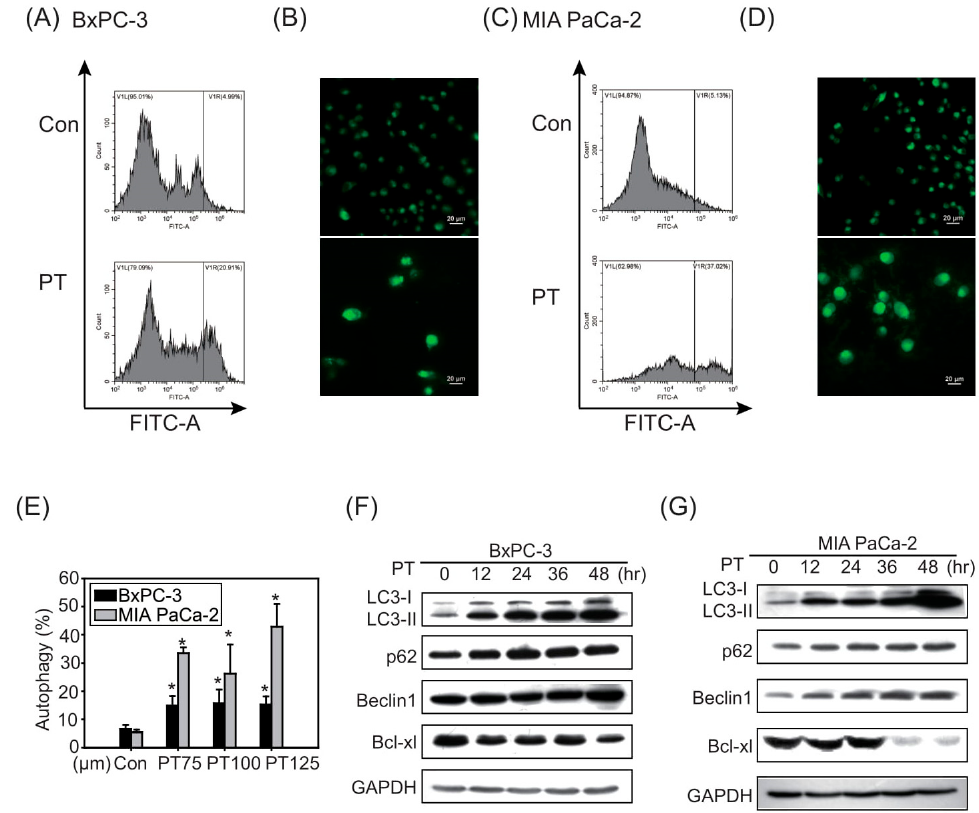
Figure 2. Autophagy was induced in response to PT treatment. The development of AVOs (acidic vesicular organelles) in ( A ) BxPC-3 and ( C ) MIA PaCa-2 pancreatic cancer cells after PT treatment for 24 h was analyzed via flow cytometry and ( E ) histogram indicate the percentage of autophagy positive cells via flow cytometry; * p < 0.05 compared to the control group. ( B , D ) Detection of autophagy in both cell lines via fluorescence microscopy at 400 × magnification (scale bar = 50 µ M). Western blot analysis of LC3-I, LC3-II, p62, Beclin 1, and Bcl-xl was conducted in ( F ) BxPC-3 and ( G ) MIA PaCa-2 cells treated with PT (100 µ M) for 48 h. The membrane was probed with anti-GAPDH to confirm equal loading of proteins. Immunoblots are representative of at least three independent